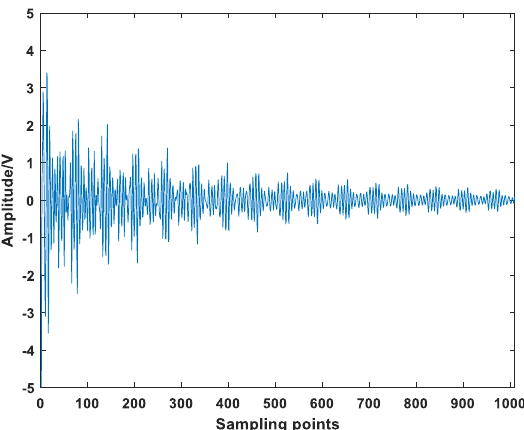
Figure-12. D2 layer reconstruction attenuation component.